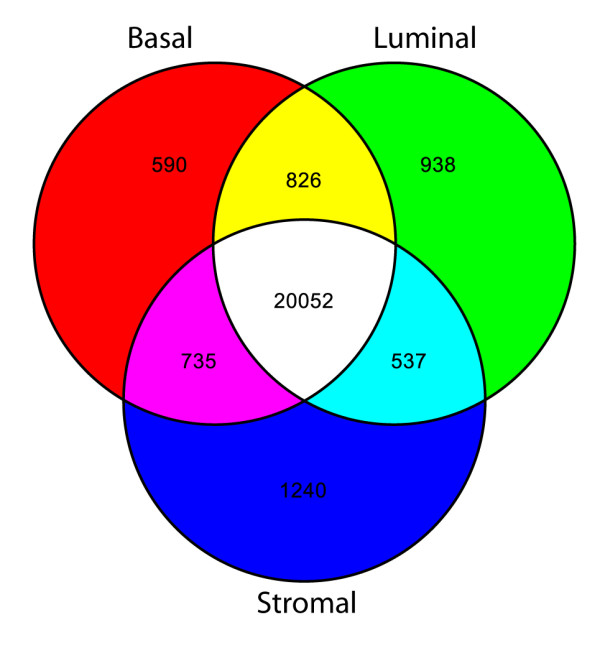
Similarity of prostate cell transcriptomes. A Venn diagram depicting the number of genes expressed by each prostate cell type: basal (red), luminal (green), and stromal (blue). Intermediate colors represent groups of genes that are shared between two cell types. Genes expressed by all prostate cell types are white. The transcriptomes of luminal cells are more similar to basal cells than stromal cells.